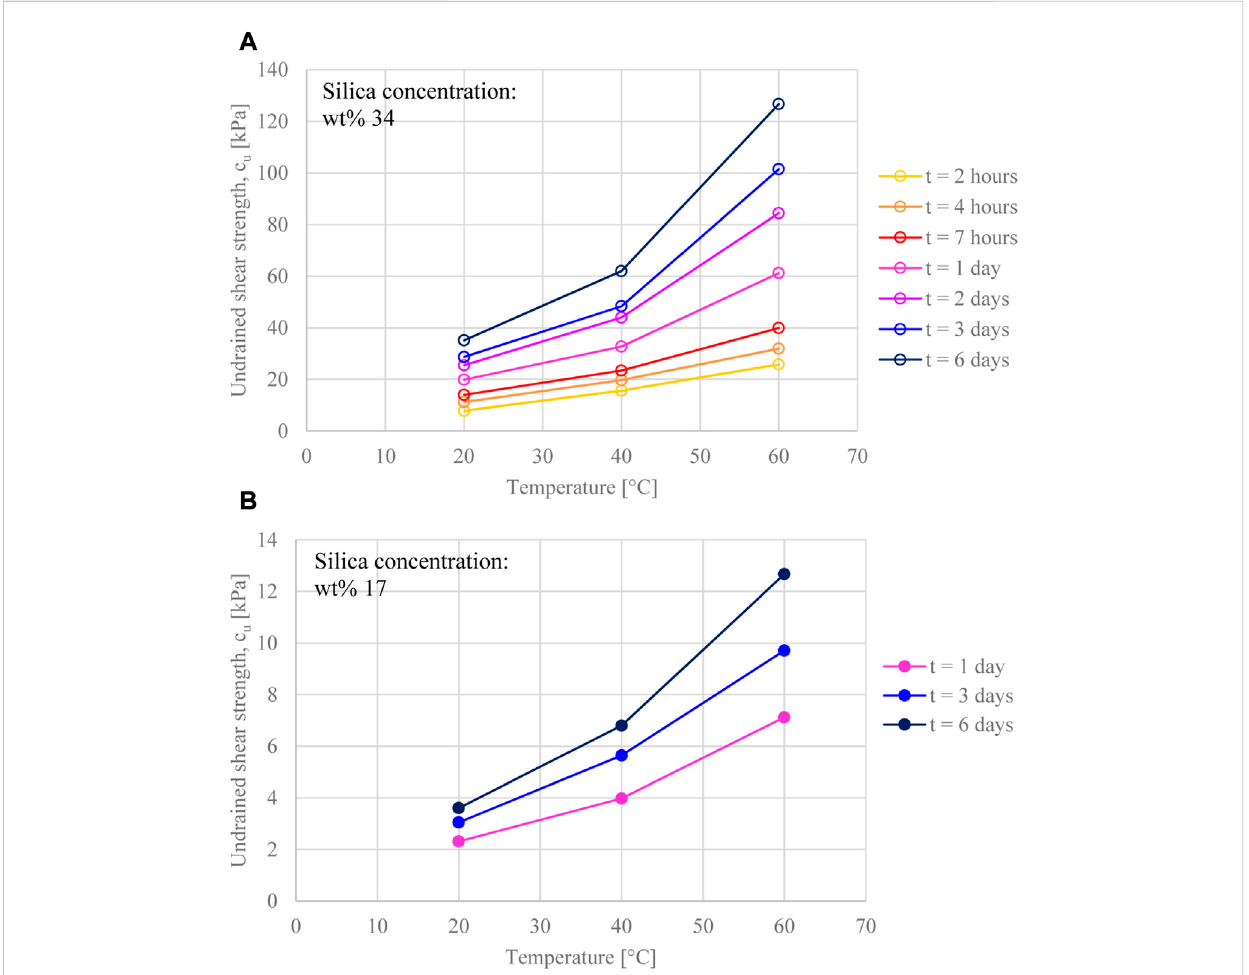
FIGURE 7 Undrained shear strength evolution against temperature at different curing time, for gel samples at silica concentration (A) wt% 34, and (B) wt% 17.